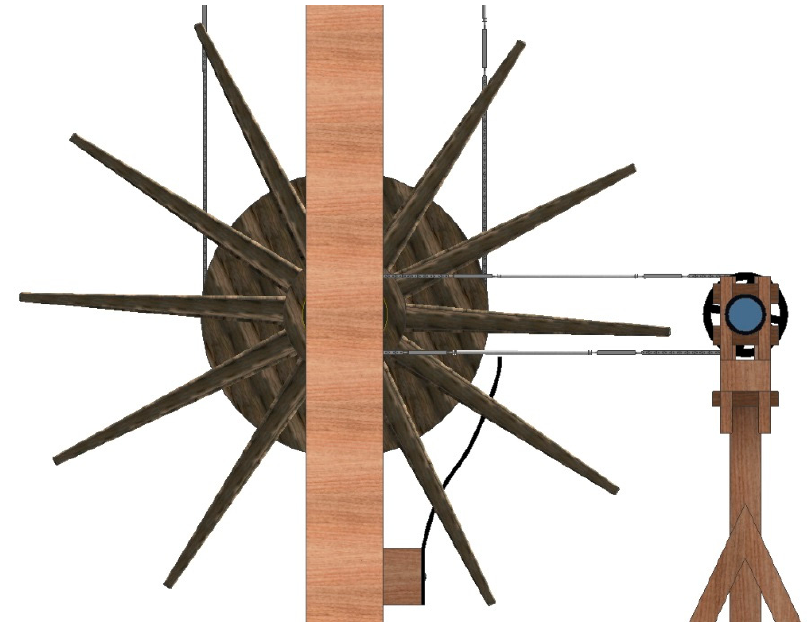
Figure 19. Turning ratio between the winch and the telescope pulley.